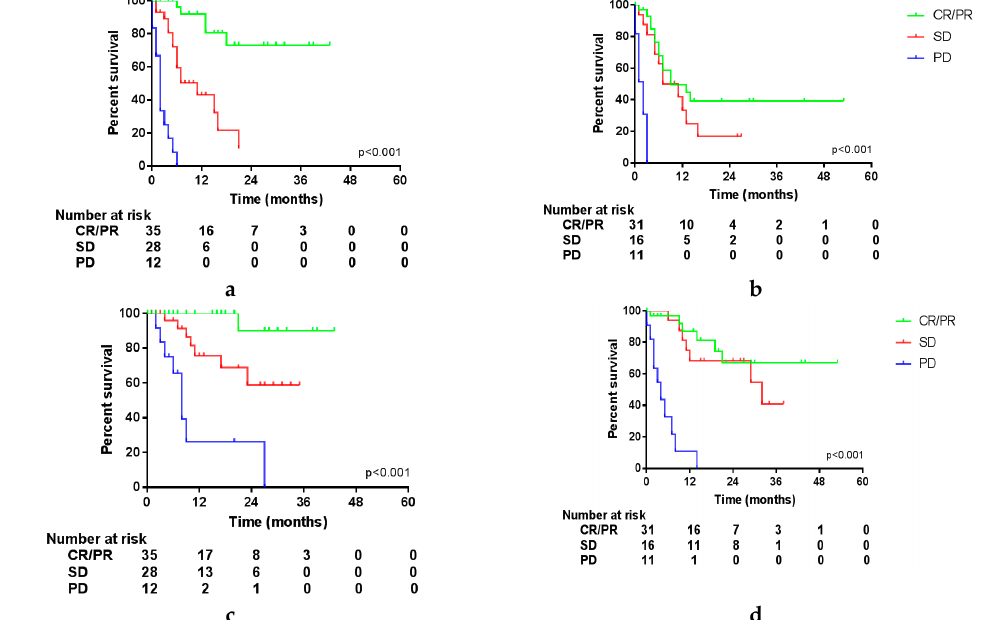
Figure 2. Survival per status of disease at first follow-up after surgery. ( a ) Progression-free survival (PFS) in patients treated with ICI; ( b ) PFS in patients treated with targeted therapy; ( c ) overall survival (OS) in patients treated with ICI; ( d ) OS in patients treated with targeted therapy.